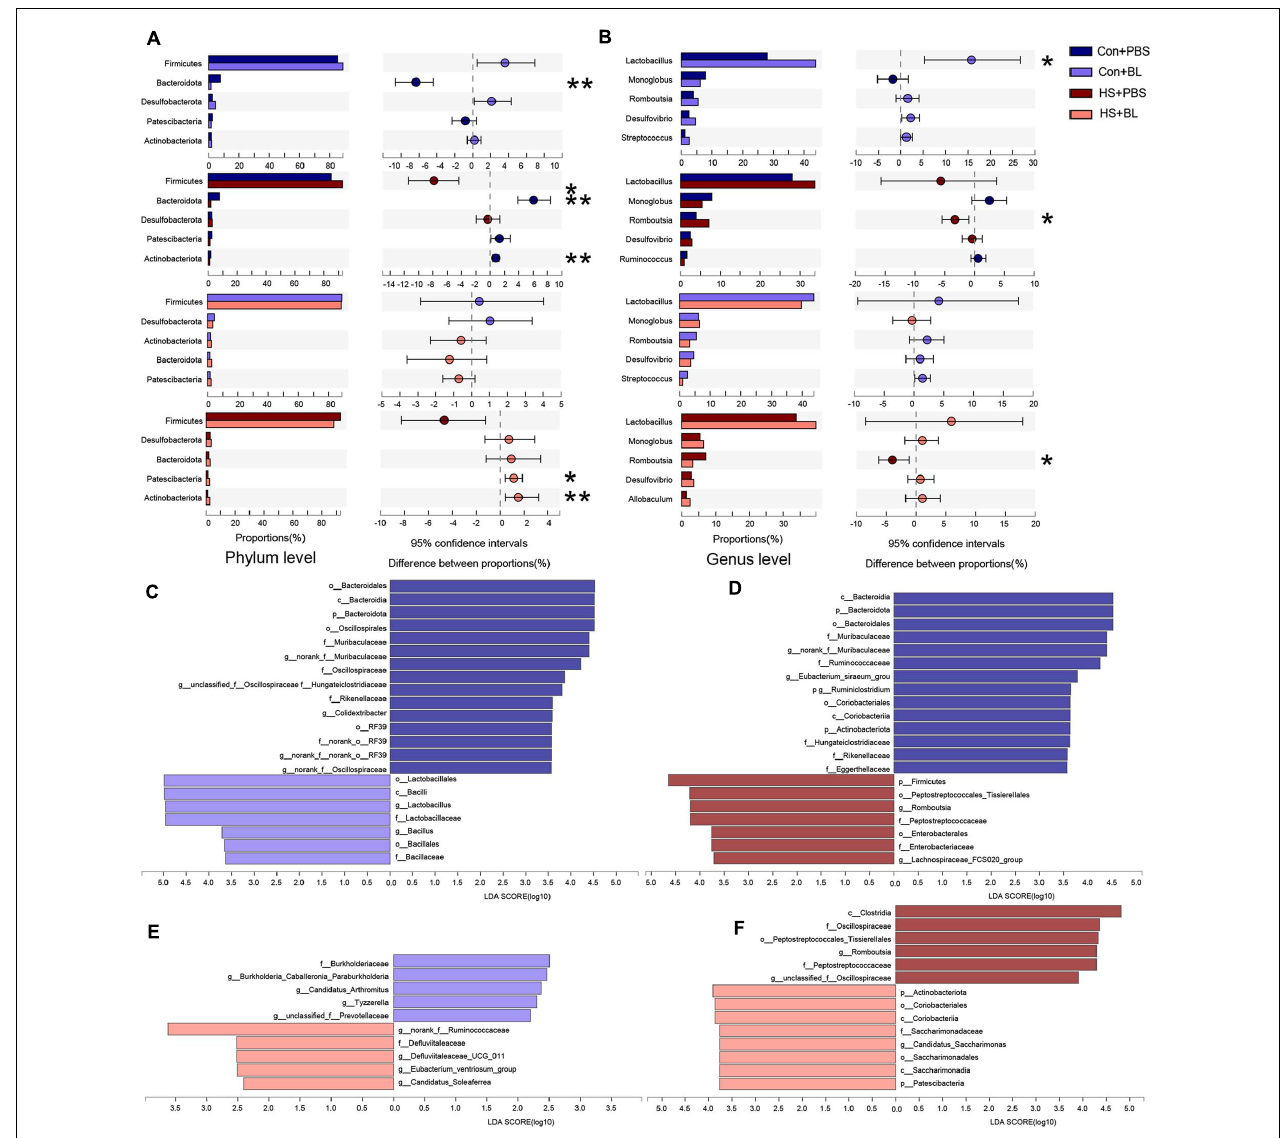
FIGURE 7 | Pairwise comparisons of gut microbiota compositions between each group. (A,B) Mean relative abundances of the five most abundant phyla and genera (non-ranked or unclassified types were excluded) are shown by extended error bar plot and were compared between two groups at the phylum and genus levels. (C–F) Gut microbiota comparisons from phylum to genus between two groups by linear discriminant analysis effect size (LEfSe) analysis. Linear discriminant analysis (LDA) scores for the differentially abundant bacterial taxa between two groups were calculated by LEfSe to assess the effect size of each differentially abundant taxon. Only taxa having a p -value < 0.05 and LDA > 3.5 are shown in (C,D,F) , except (E) uses LDA > 2.0 due to the subtle difference in this comparison. Only taxa meeting an LDA significance threshold of 2 were included and shown. Enriched taxa in each group are indicated in red or blue. n = 6 in each group. * P < 0.05, ** P <